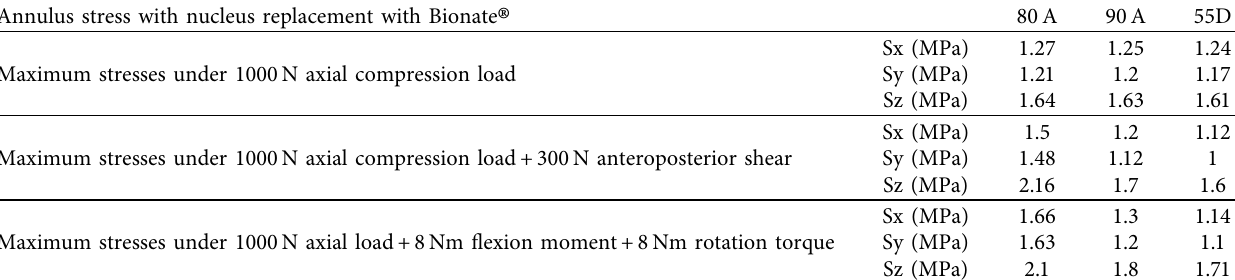
Table 2: Maximum annulus stresses with the selected design nucleus replacement made of Bionate ® 80 A, 90A, and 55D. Annulus stress with nucleus replacement with Bionate ®